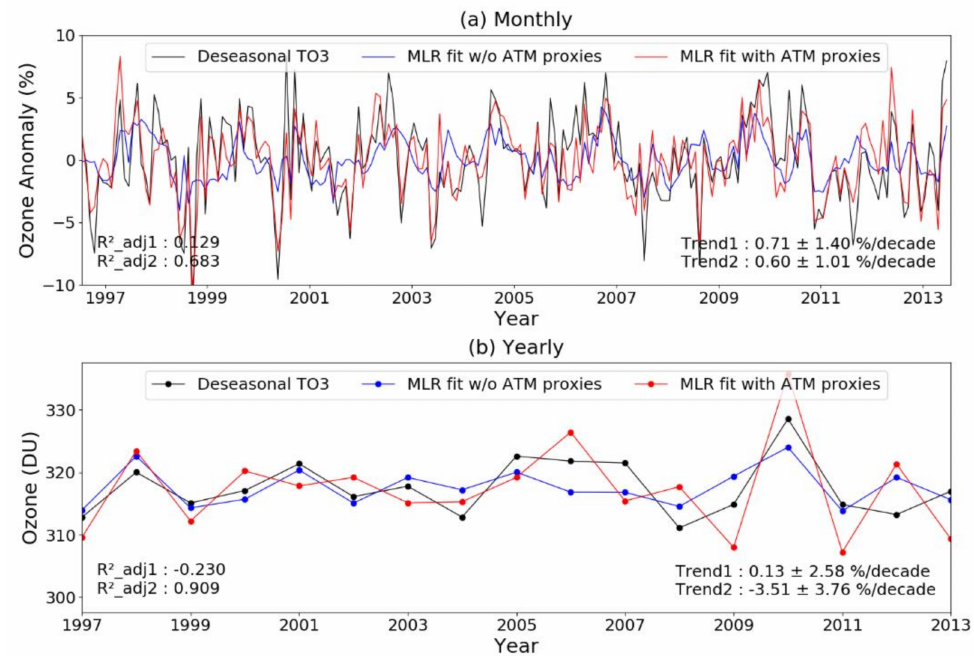
Figure 5. Time-series of TOMS/OMI/OMPS total column ozone passing over the Pohang station according to the use of atmospheric proxies. Both the monthly ( a ) and yearly ( b ) MLR fitted data are presented for comparison. The MLR fitted data without atmospheric proxies are indicated as blue lines and correspond to Trend1 and R 2 _adj1 while the MLR fitted data with the atmospheric proxies are indicated as red lines and correspond to Trend2 and R 2